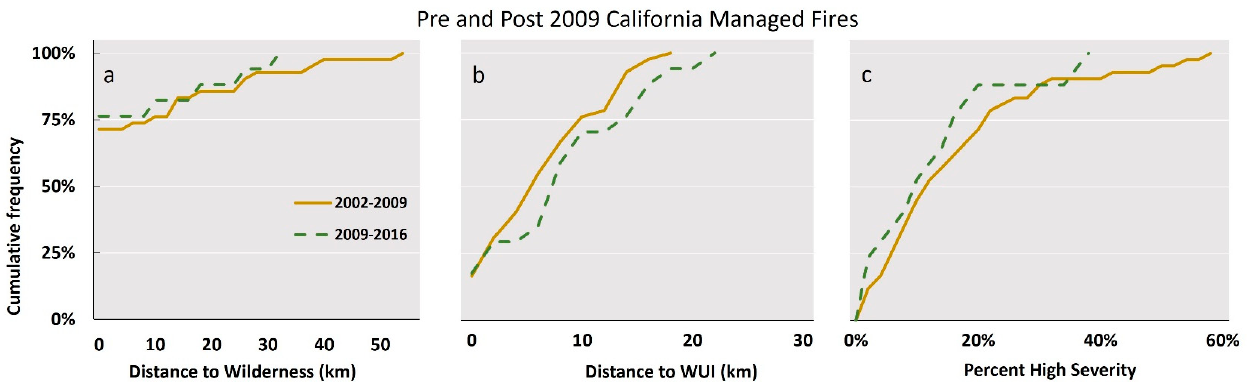
7 of 14 Figure 3. Comparison of managed wildfires in California ( n = 59) and the Southwest ( n = 195) based on ( a ) distance to wilderness, ( b ) distance to WUI, and ( c ) the percentage of high-severity burn area. Managed wildfires in California were closer to the wilderness and had a smaller percentage of high- severity fire but were not different in terms of distance to WUI compared to managed wildfires in the Southwest. 3.3. Managed Wildfires Pre- and Post-2009 Policy Guidance 3.3.1. California Within California, our analysis included 42 managed wildfires from 2002 to 2008 and 17 from 2009 to 2016. Most managed wildfires in California, pre- (71%) and post-2009 (76%), burned within a wilderness area, at least in part (Figure 4a). Most were also within 20 km of wilderness, both pre- (86%) and post-2009 (88%). Similarly, at least 70% of managed wildfires were within 10 km of WUI before and after 2009. In terms of fire severity (Figure 4c), the median (50th percentile) was 14% of the area being burned at high severity for managed wildfires in California pre-2009 and was not significantly different